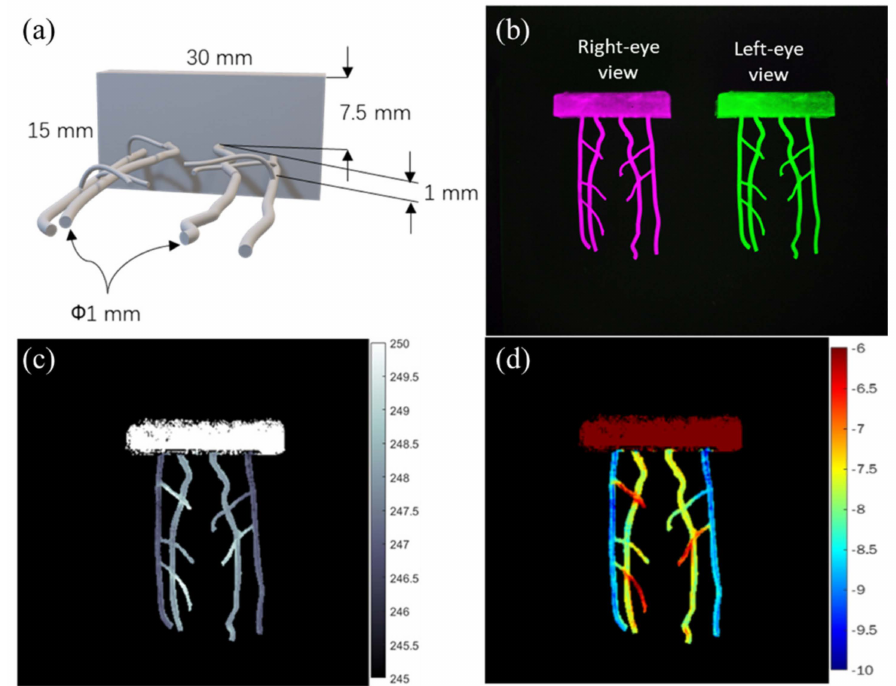
Figure 5. Results of blood vessel phantom study: ( a ) design of 3D printing phantom, ( b ) left eye- and right eye-view images, ( c ) disparity map of blood vessels phantom, and ( d ) depth map of blood vessels